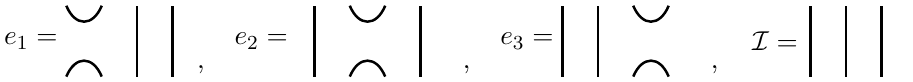
Figure 17 . The graphical interpretation of the Temperley-Lieb loop